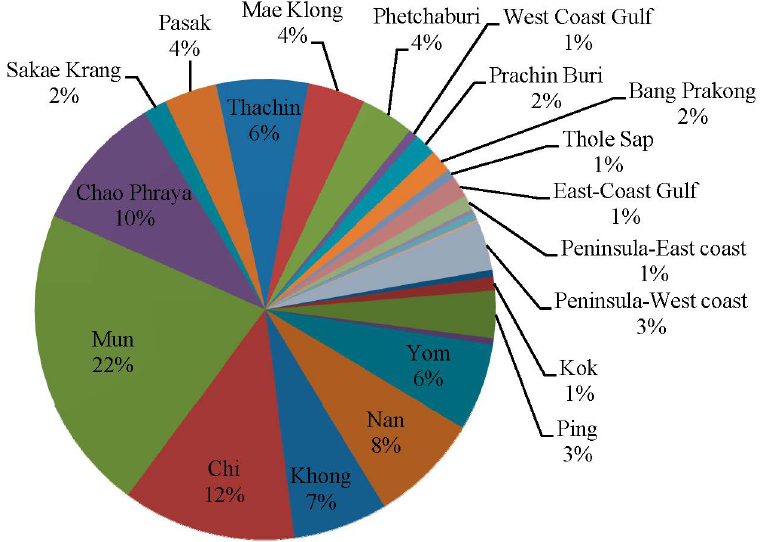
Figure 5. Share of irrigation water requirements for staple crops production in 2012 classified by watersheds.